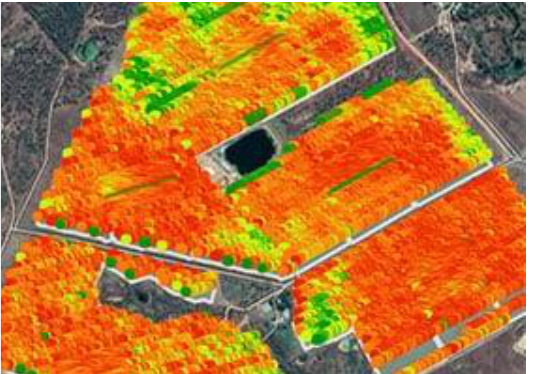
Figure 1. The technique of in-field machine is now being applied to assessment of fruit and flower load of whole farms. Colours refer to fruit density, from green (low) through yellow to red (high). Koirala et al. [7] explored the use of techniques to correct for occluded fruit, for example, by the use of a machine-vision-based measure of the fraction of partially occluded to non-occluded fruit. None of the proposed techniques were recommended for adoption, and this topic remains open.